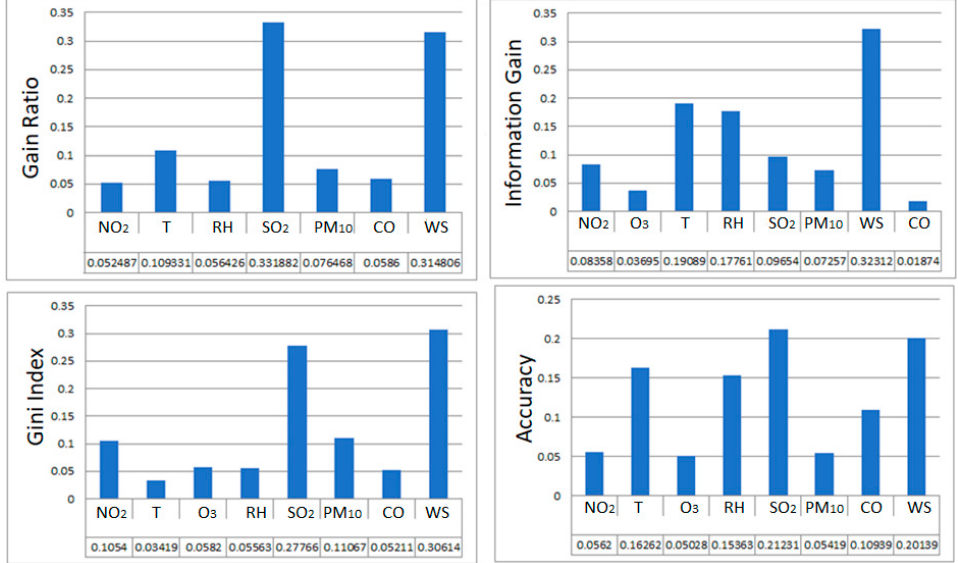
Figure 4. Feature importance for eight parameters (decision tree (DT) model).